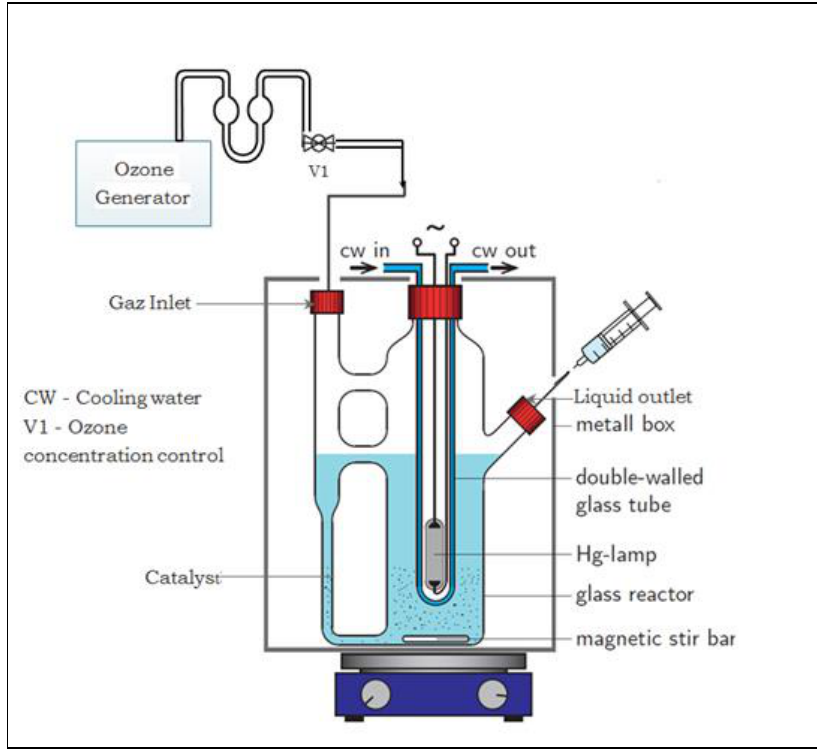
Figure 2. Scheme of the reactor used for imazapyr degradation.